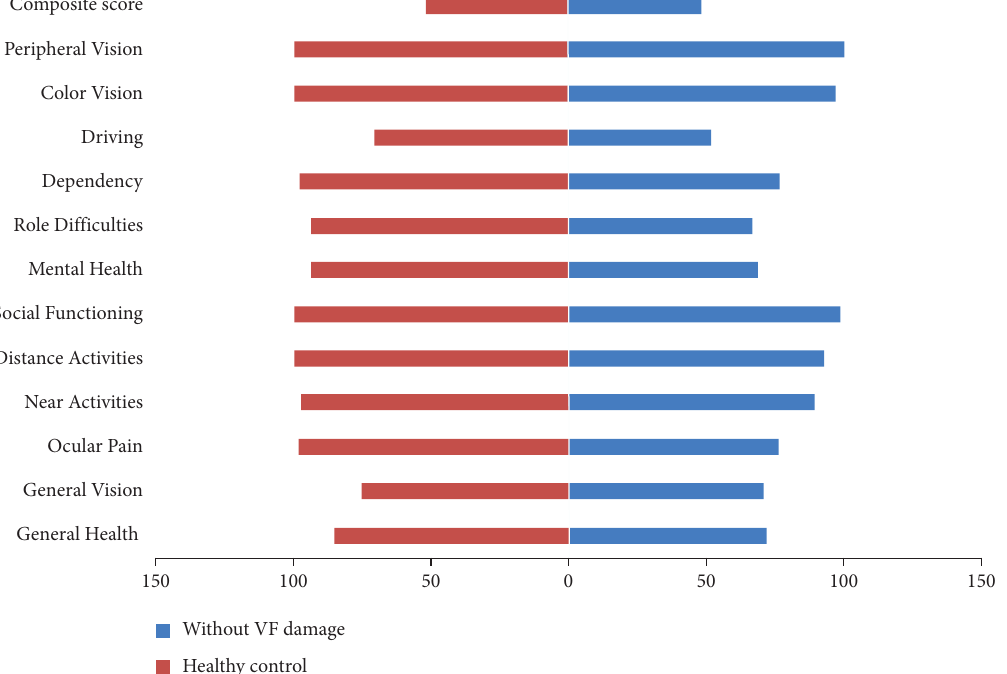
Figure 3: Te average scores of the NEI VFQ-25 between PACG patients without visual feld defects and healthy